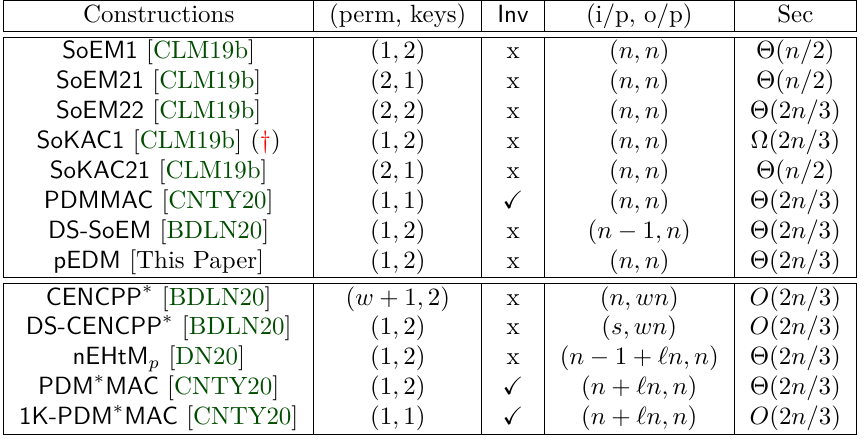
Table 1: Comparison table for permutation based PRFs. n denotes the state size of the permutation. Inv denotes whether the construction requires an inverse call of the permutation. s ∆ = n − log( w + 1), where w ≥ 1, is the size of chunk in CENC